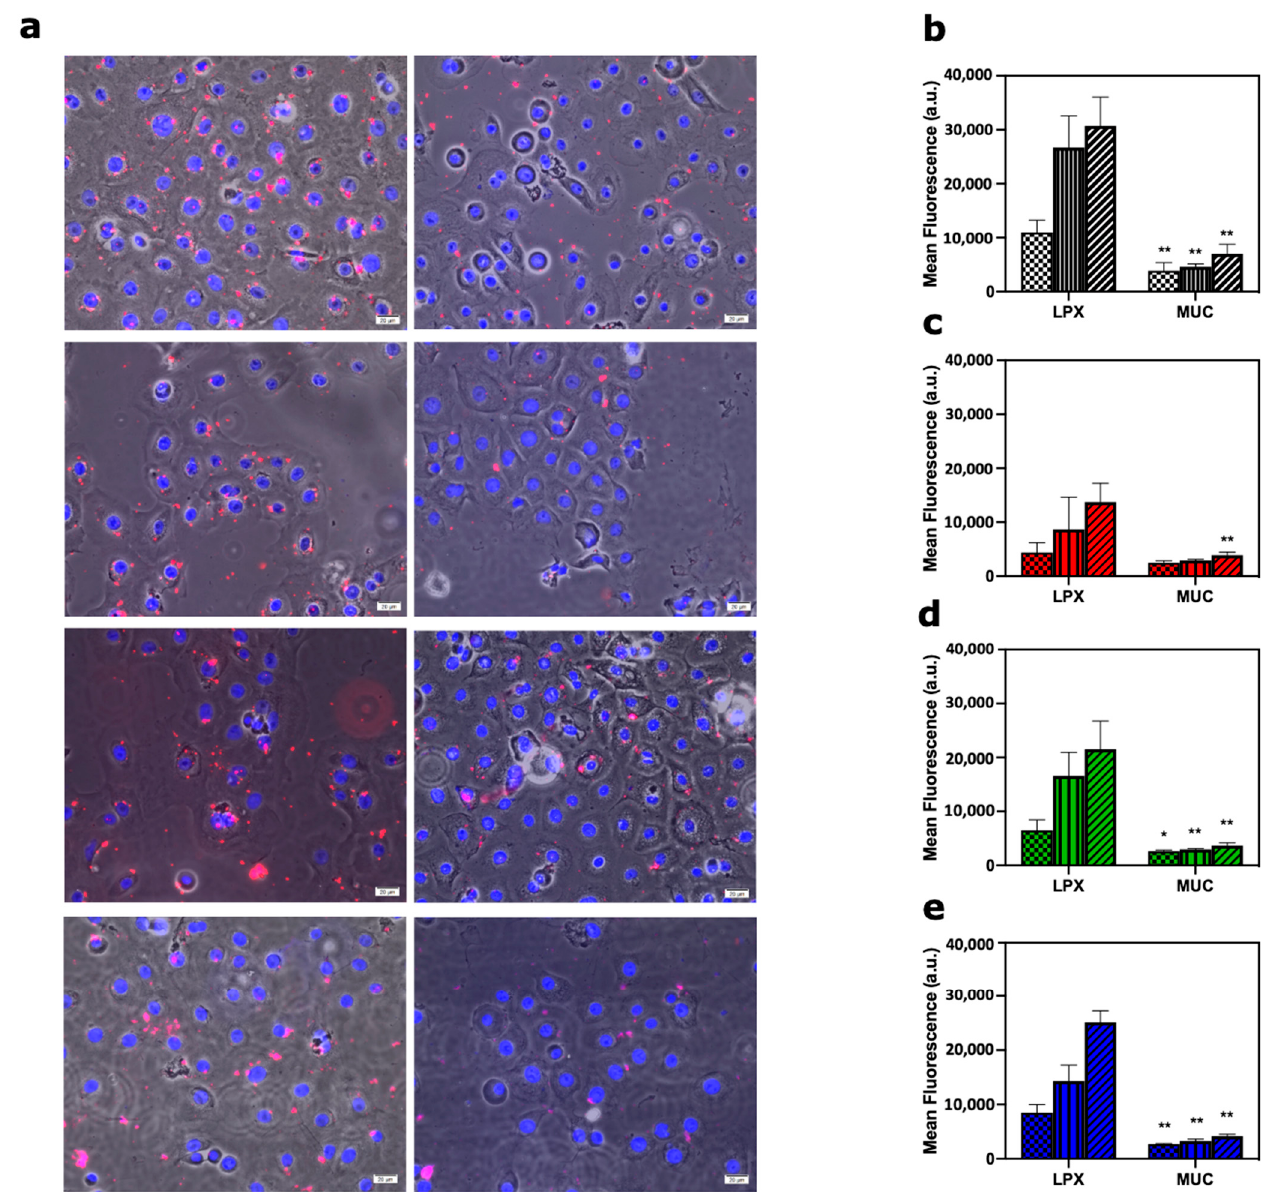
Figure 2. Representative images for subcellular localization of fluorescently labelled (red) pristine-LPX and MUC- biocoronated lipoplexes in primary corneal epithelial cells after 60 min treatment. Cell nuclei were stained with DAPI. Scale bars are 20 microns. ( a ) Mean fluorescence FACS analysis acquired by 635 nm laser excitation (filter 655–730 nm) was performed to assess the uptake by primary corneal epithelial cells following treatment with Pristine LPX and MUC- biocoronated LPX at three incubation times (30, 60 and 90 min). LPX1( b ); LPX2 ( c ); LPX3 ( d ); LPX4 ( e ). Results are given as average of N = 3 independent measurements ± standard deviation. Statistical differences were determined by Student’s t test: p < 0.05 was considered significant (*) and p < 0.001 was consider strongly significant (**).